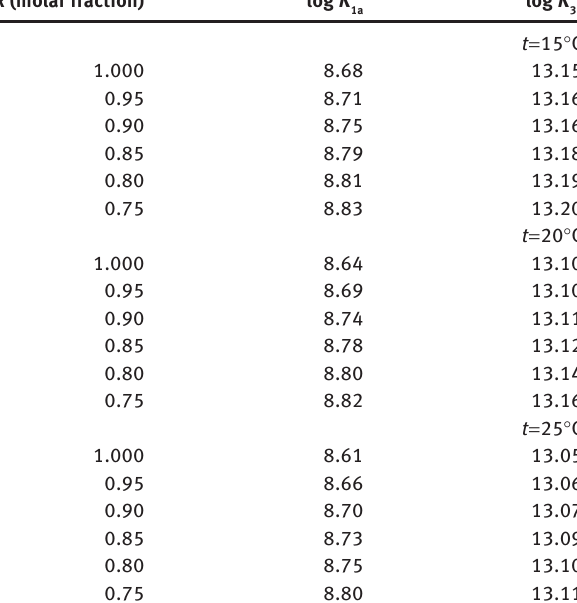
deviations (0.01) in ( x ) water + (1- x ) ethanol at different temperatures and I = 0.2 mol.dm -3